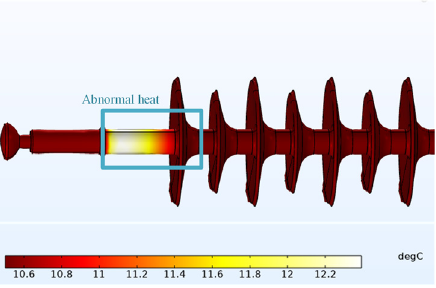
Figure 12. Simulation diagram of #2’s temperature rise.